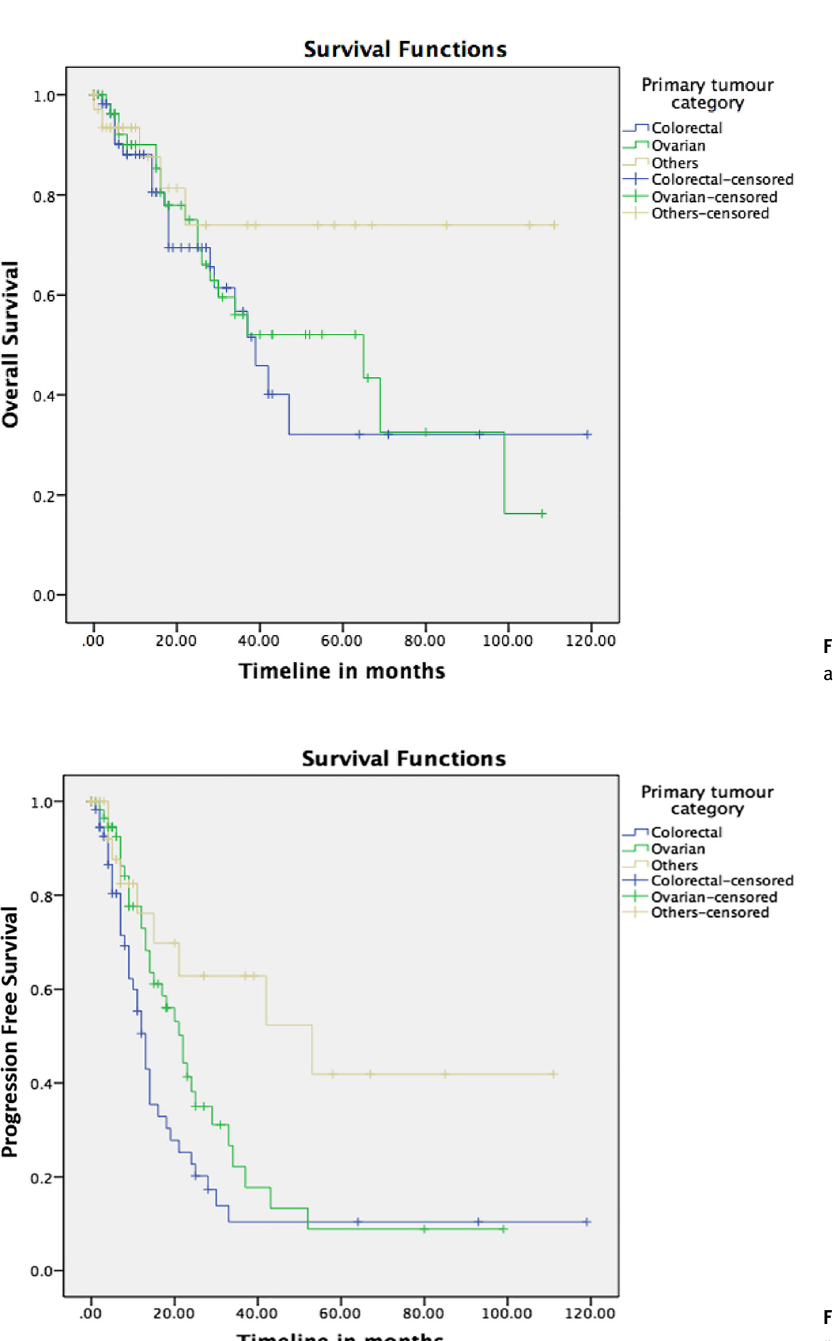
Figure 3: Progression free survival (PFS) of patients after CRS and